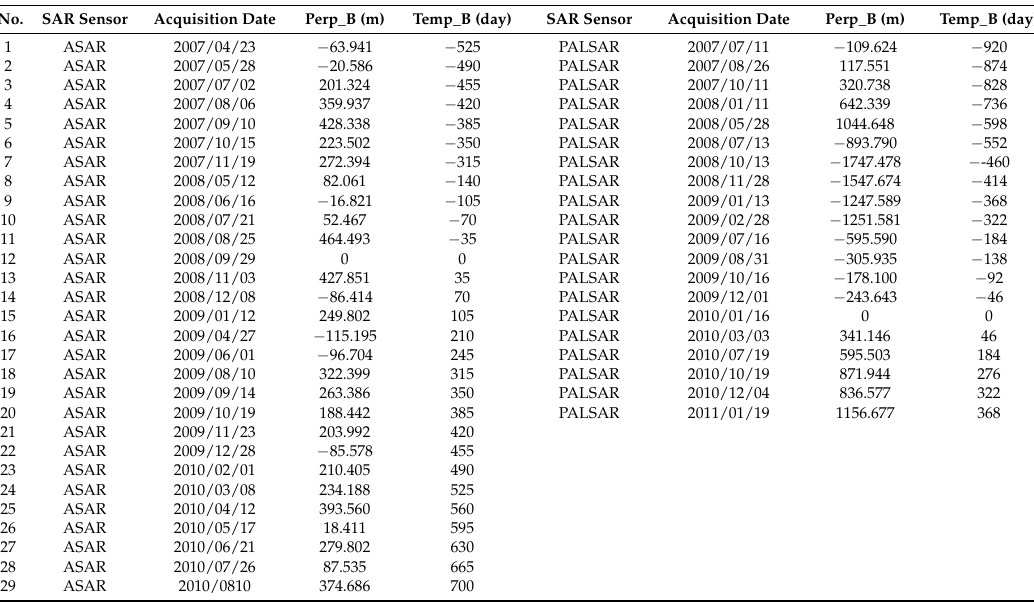
Table A2. ASAR/PALSAR data information. Perp_B (m) denotes the Perpendicular Baseline (m) and Temp_B (day) represents the Temporal Baseline